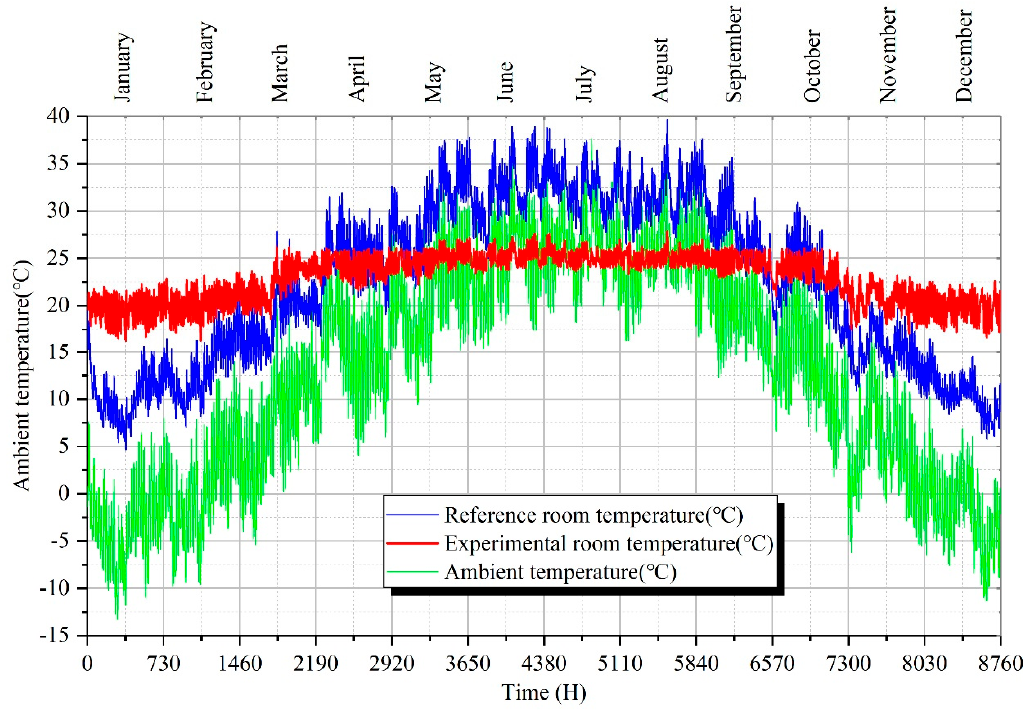
Figure 5. The temperatures of experimental, reference room, and ambient throughout one year.